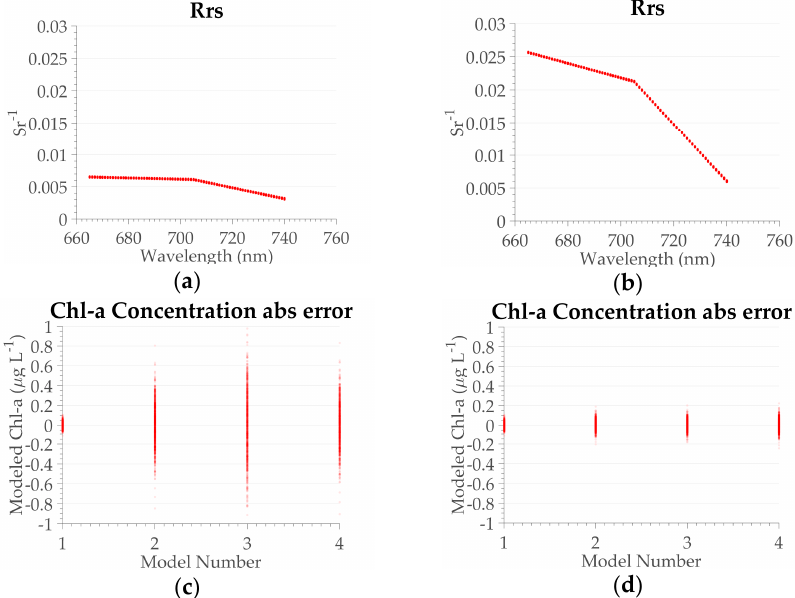
Figure 7. Example of the OLCI R rs magnitude and Chl-a concentration obtained for the four models for two lakes. ( a ) R rs for three bands for one sample station of Bua-Buá, ( b ) R rs for three bands for one sample station of Pirarara, ( c ) Chl-a concentration for the Bua-Buá sampling point, ( d ) Chl-a concentration for the Pirarara sampling point. The numbers 1, 2, 3, and 4 refer to the CLH , 2B, 3B , and NDCI models, respectively.